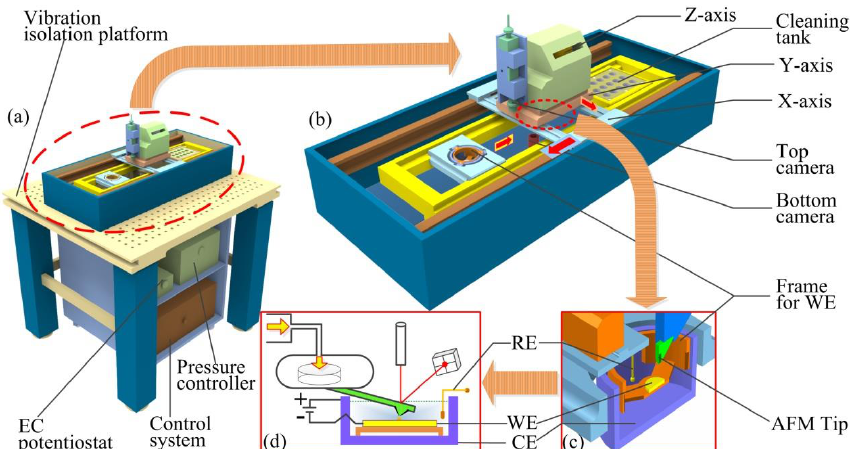
Figure 1. Schematic model of the localized electrochemical deposition based on the hollow AFM probe. ( a ) The whole view of the electrochemical deposition system. As a brain of the whole system, the control system decides where and what shape to print and how big to manufacture, and controls all the subsystems. The vibration isolation platform is the base for the whole printing system. The EC (electrochemical) potentiostat maintains a stable potential difference between the RE ( quasi-reference electrode ) and WE (working electrode). The pressure controller is connected to the end of the AFM cantilever. The amplitude of the pressure can control the volume throughput from the tip of the FluidFM. ( b ) The enlarged view of the printer displaying the key components in more detail. The X-axis and Y-axis represent the same level of precision having a repeat positioning accuracy of +/- 250 nm. The Z axis has high precision in repeat positioning up to 5nm. The cleaning tank is used for cleaning the AFM tip during the electrodeposition process. Moreover, the top and bottom cameras are used to monitor the manufacturing and assembly processes. ( c ) The cross-section of the printing chamber. When it is working all the electrodes are emerged under the acid solution. RE denotes the reference electrode, CE (counter electrode) is the counter electrode connecting the positive pore of the power, and WE is the working electrode linking to the negative pore of the power. The AFM tip is the key part of the whole technology because the metal salt solution comes from the hollow AFM probe. The frame of the WE is also important for insulation of three electrodes in electrodeposition process. ( d ) The schematic diagram of the localized electrochemical deposition based on the hollow AFM probe.